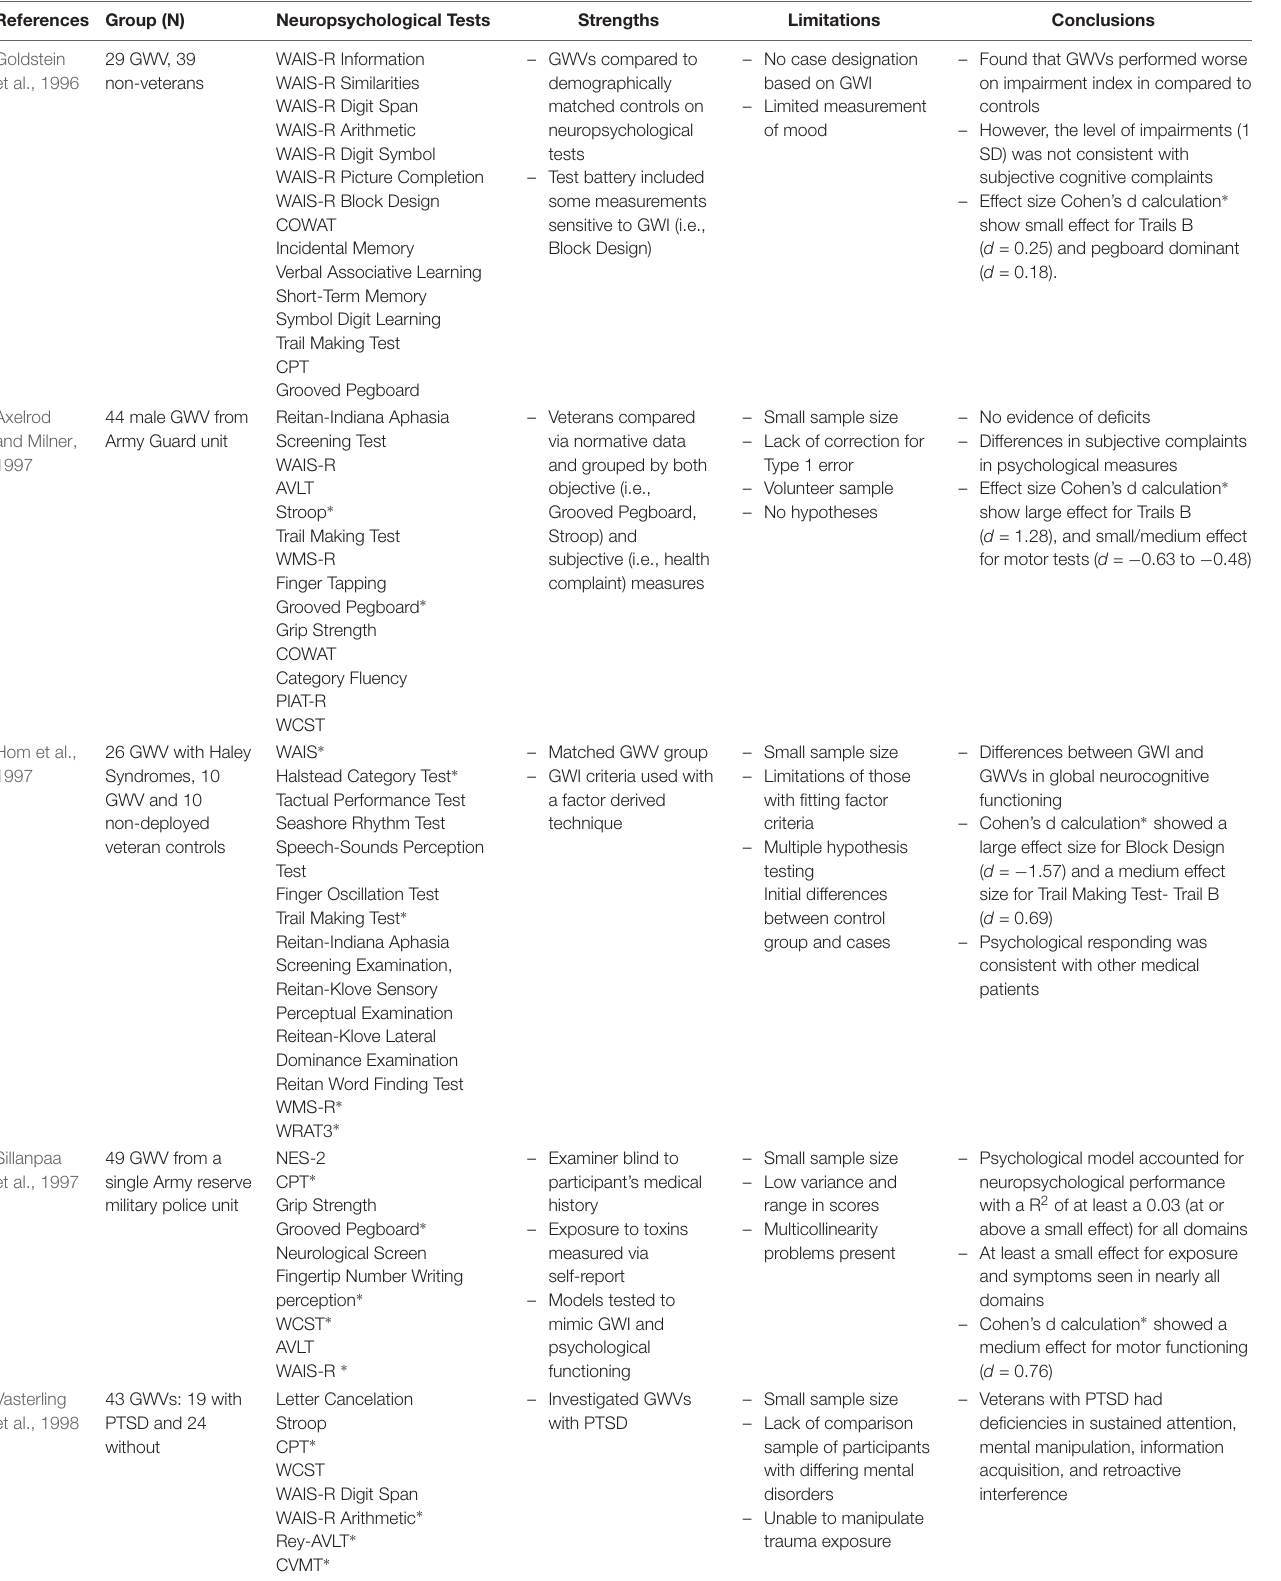
TABLE 3 | Neuropsychological studies with Gulf War